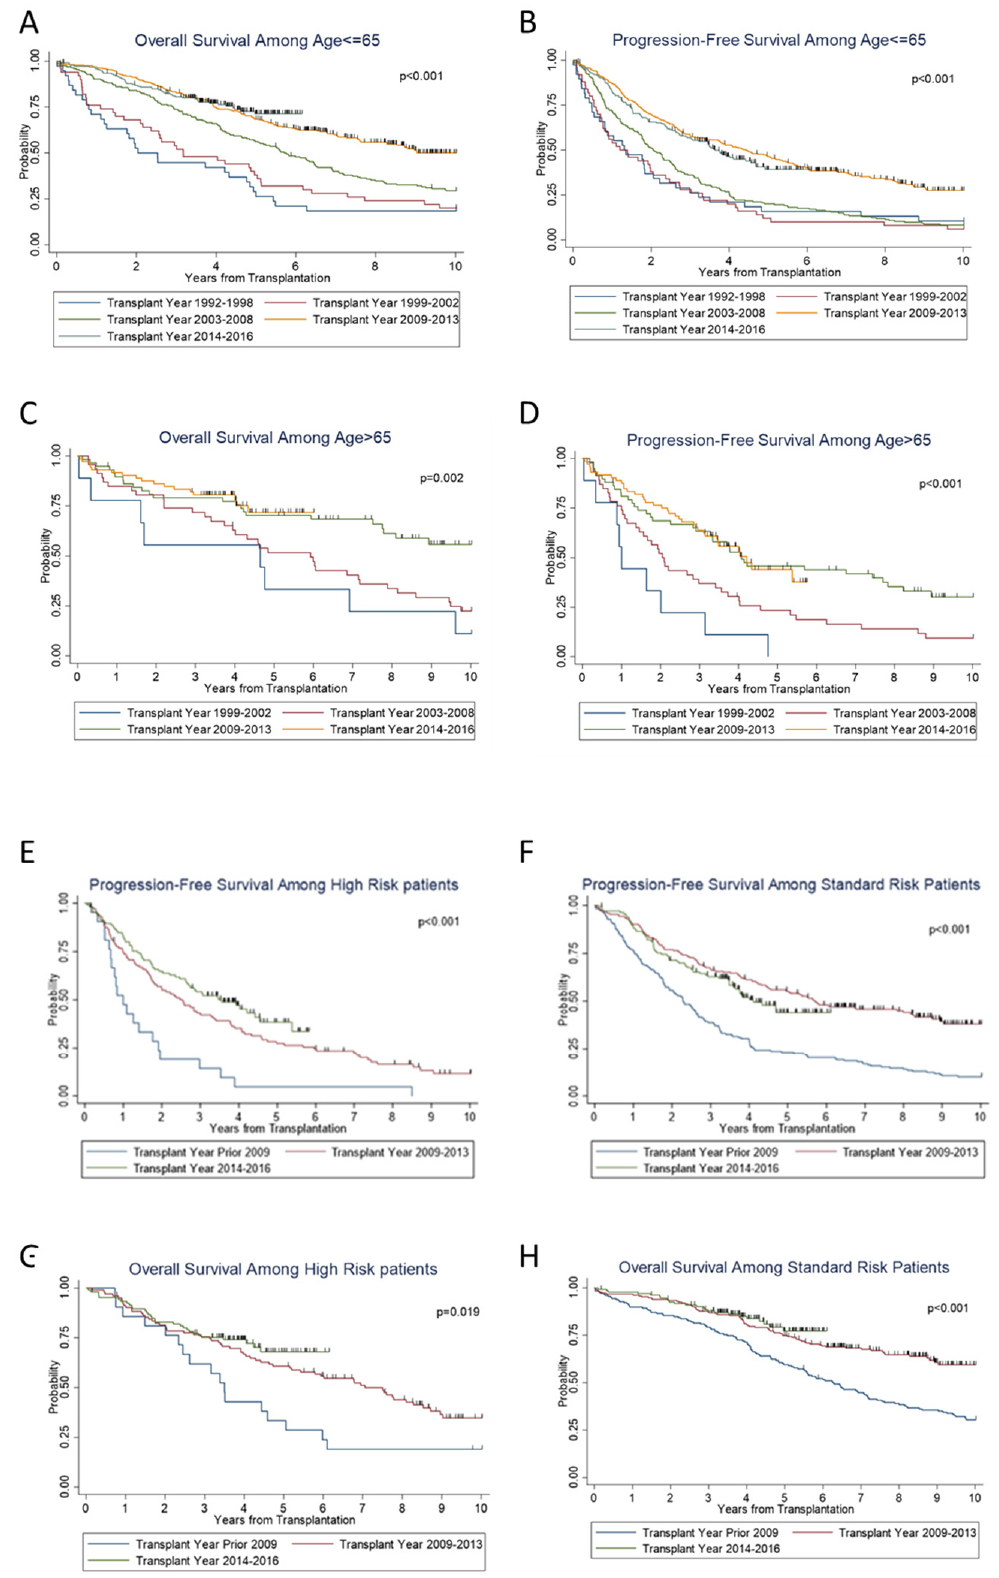
Figure 2. Subgroup survival outcomes and prognostic factors for survival.